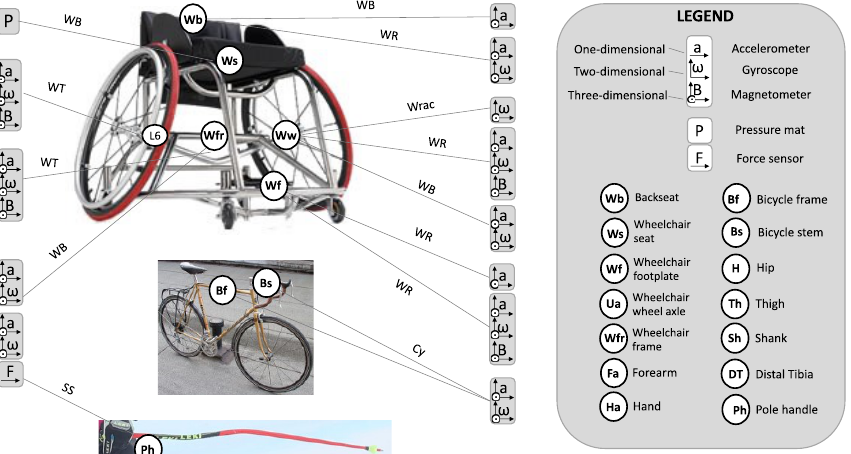
Figure 4. Configuration and positioning of wearable sensors mounted on sports equipment. WB = Wheelchair basketball [41,42,49,64,73]; WR = Wheelchair rugby [43–45,66]; WT = Wheelchair